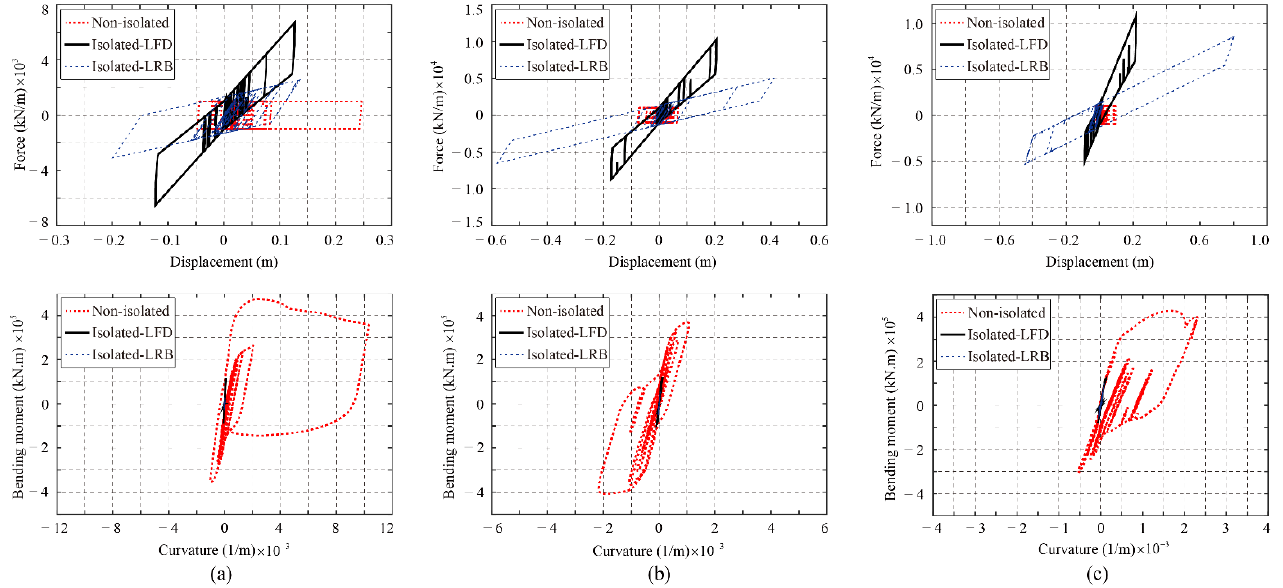
Figure 11. Force–displacement relationship of the continuous girder bridge for the original system (Non-isolated), LFD system (Isolated-LFD), and LRB system (Isolated-LRB) with ( a ) wave 4, ( b ) wave 9, and ( c ) wave 14 in Table 1.